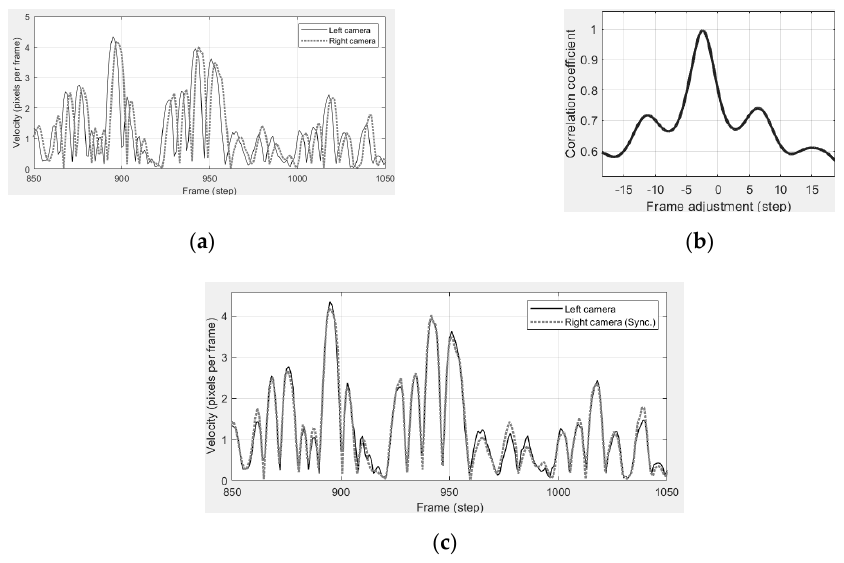
Figure 6. Synchronization by shifting image coordinate histories of the right camera. The proposed synchronization method estimates the time difference between cameras by applying cross correlation on analyzed moving velocity. ( a ) Non-synchronized movement. ( b ) Correlation vs. time lag. ( c ) Synchronized movement.